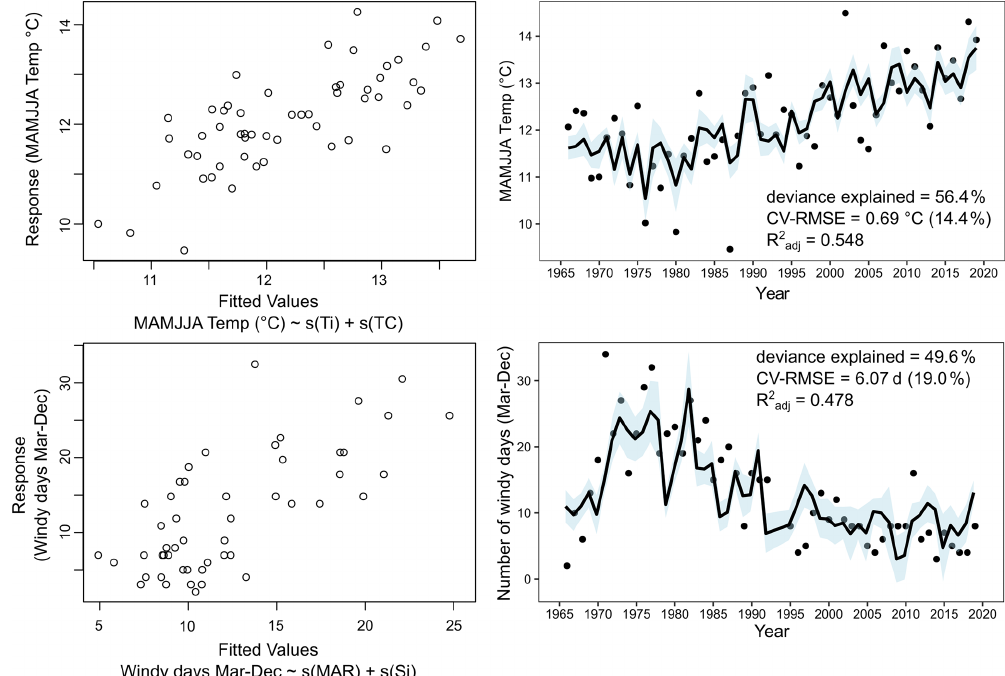
Figure 7. Results of generalized additive models used to predict spring and summer temperature and number of windy days from March to December (daily mean wind speeds > 7ms − 1